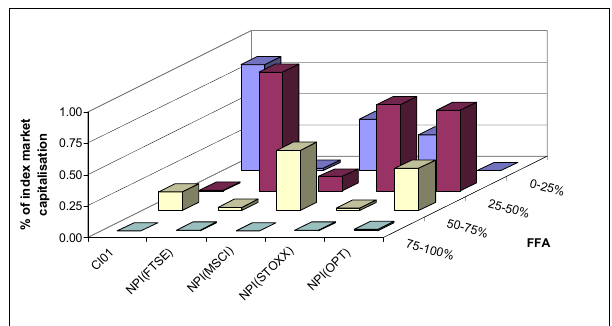
Figure 5: Analysis of CI01 and NP indices by FFA The respective biases of the FTSE and STOXX rules towards mid and low free float stocks implied the development of a less that optimal index. In contrast, the MSCI and optimum normal portfolio rules resulted in an index with an improved spread of free float stocks.